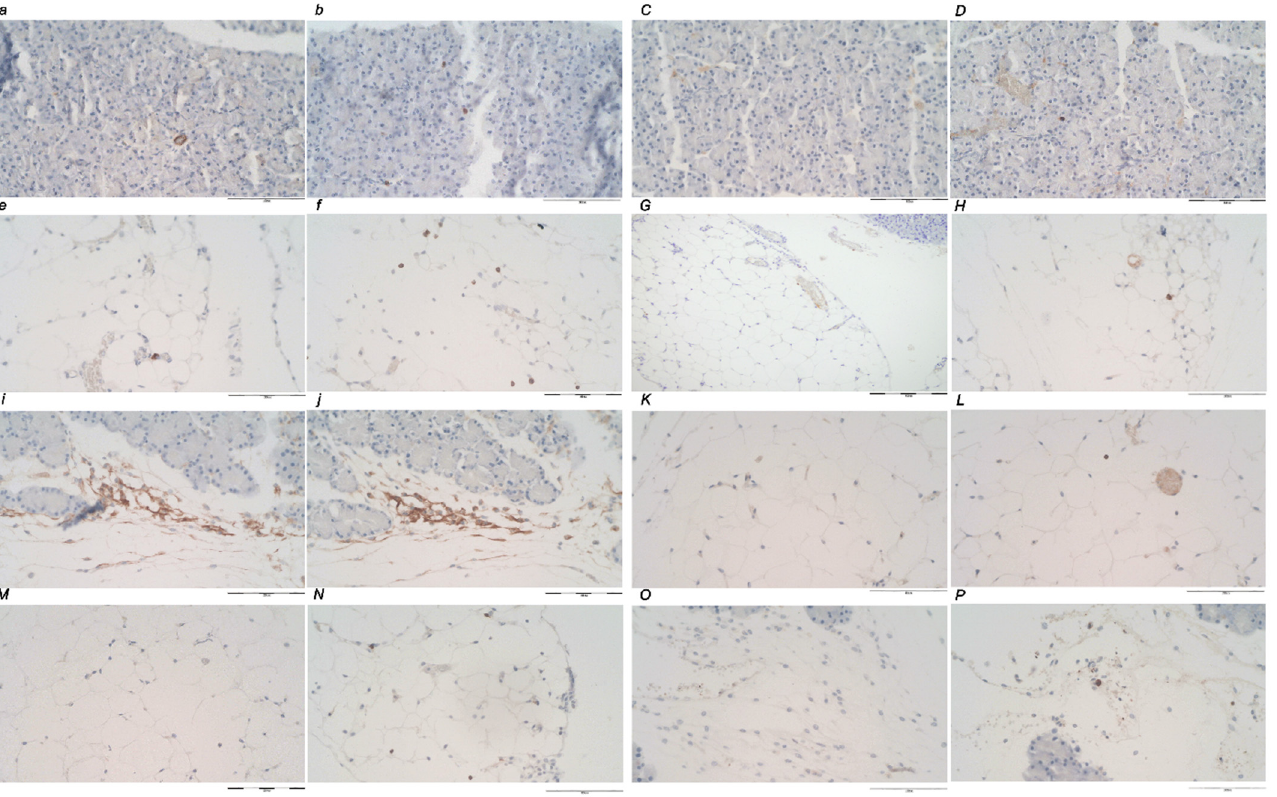
Figure 17. CD20- and CD3-positive cells’ illustrative immunochemistry presentation in rats with obstructed bile duct ( a – P ) at the end of the ligation time periods of 30 min, 5 h, and 24 h; as an early regimen at 0–30 min ( a – D ), 0–5 h ( e – H ), and 0–24 h ( i – L ) application sacrifice period; and as delayed regimen at 4.30 h–5 h ( M , N ) and 5 h–24 h ( O , P ) application sacrifice period in controls ( a , b , e , f , i , j ) and BPC 157-treated rats ( C , D , G , H , K – P ). “Hot spots” at 200× magnification. ( a , b ) (control, 0–30 min). Up to 1 cell CD20-positive and 2 cell CD3-positive lymphocytes were found within pancreatic lobuli. ( C , D ) (BPC 157, 0–30 min). Only up to 1 CD3-positive lymphocyte cell was found within pancreatic lobuli with no CD20 lymphocytes. ( e , f ) (control, 0–5 h). Up to 1 CD20-positive cell and 8 CD3-positive lymphocytes ( G , H ) (BPC 157, 0–5 h). Up to 1 CD20-positive cell, and no CD3-positive lymphocytes ( i , j ) (control, 0–24 h). Considerable number of CD20-positive cells and CD3-positive lymphocytes in the peripancreatic fat tissue. ( K , L ) (BPC 157, 0–24 h). Only up to 1 CD3-positive lymphocyte cell in the peripancreatic fat tissue, but no CD20 lymphocytes. BPC 157 delayed regimens ( M – P ). ( M , N ) (BPC 157, 4.30 h–5 h). Up to 1 CD20-positive cells, and no CD3-positive lymphocytes ( O , P ) (BPC 157, 5 h–24 h). Only up to 1 CD3-positive lymphocyte cell in the peripancreatic fat tissue, but no CD20 lymphocytes.